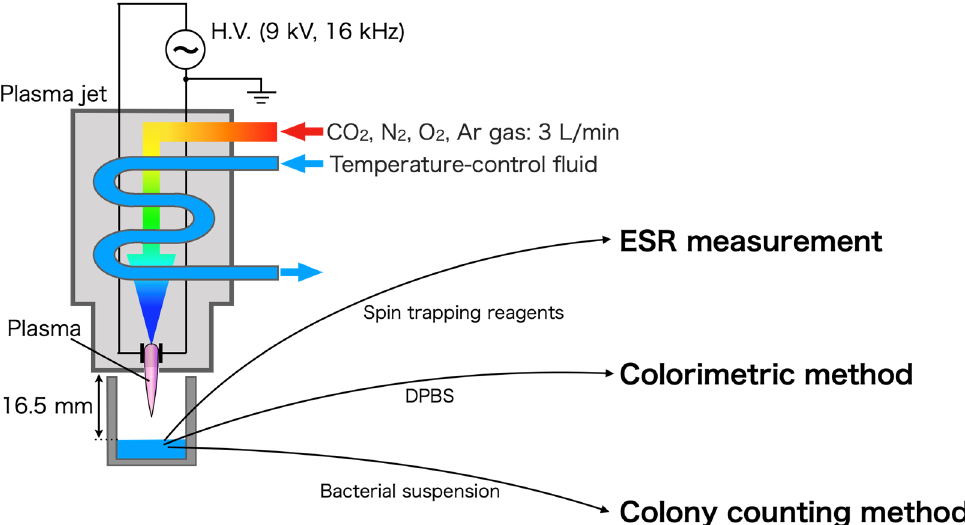
Figure 1. Overview of the plasma treatment. The spin-trapping reagents for the OH radical and singlet oxygen were 5,5-dimethyl- 1-pyrroline-N-oxide (DMPO) [17] and 2,2,5,5-tetramethyl-3-pyrroline-3-carboxamide (TPC) [18]. These reagents were dissolved in Dulbecco’s phosphate-buffered saline (DPBS) solution, and the concentrations of DMPO and TPC were fixed at 200 and 75 mM, respectively. Each 150 µL of plasma-treated spin-trapping reagent was measured using ESR within 30 s. The ESR measurement was set to a microwave frequency of 9.425 GHz, modulation frequency of 100 kHz, sweep time of 2 min, magnetic field of 335.5 ± 5 mT, and modulation width of 0.1 mT.